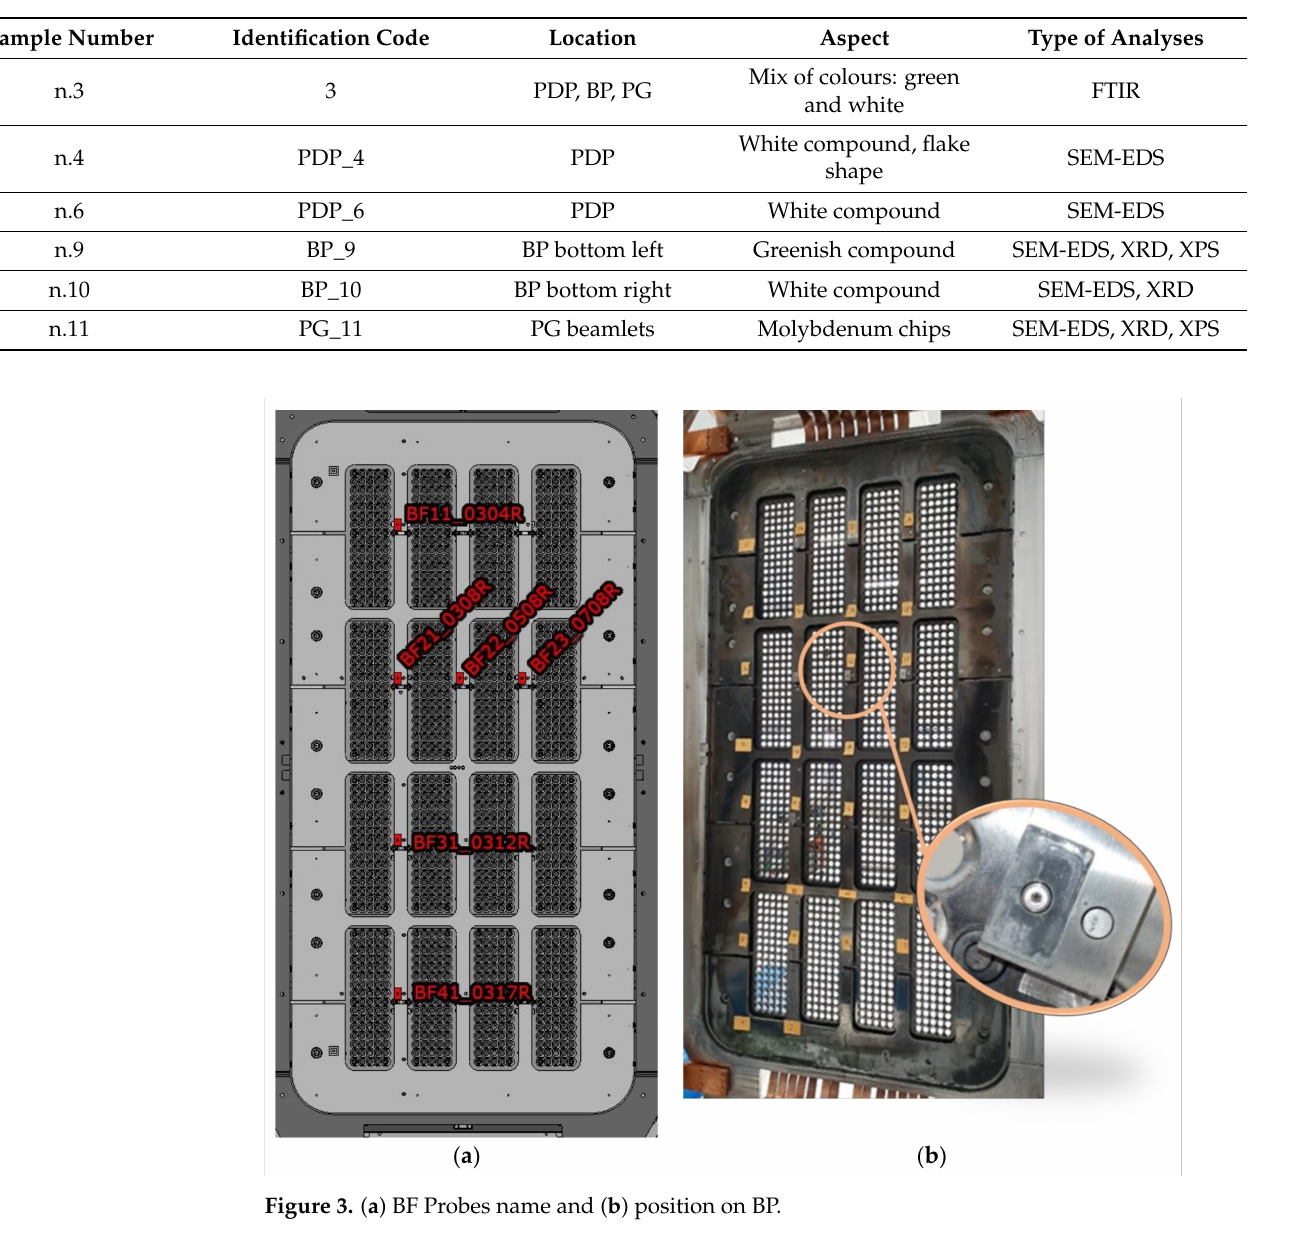
Table 1. Samples taken from SPIDER source, the identification code reminds the original location (PDP, BP and PG), except for Sample 3, which is a mixture of several compounds.